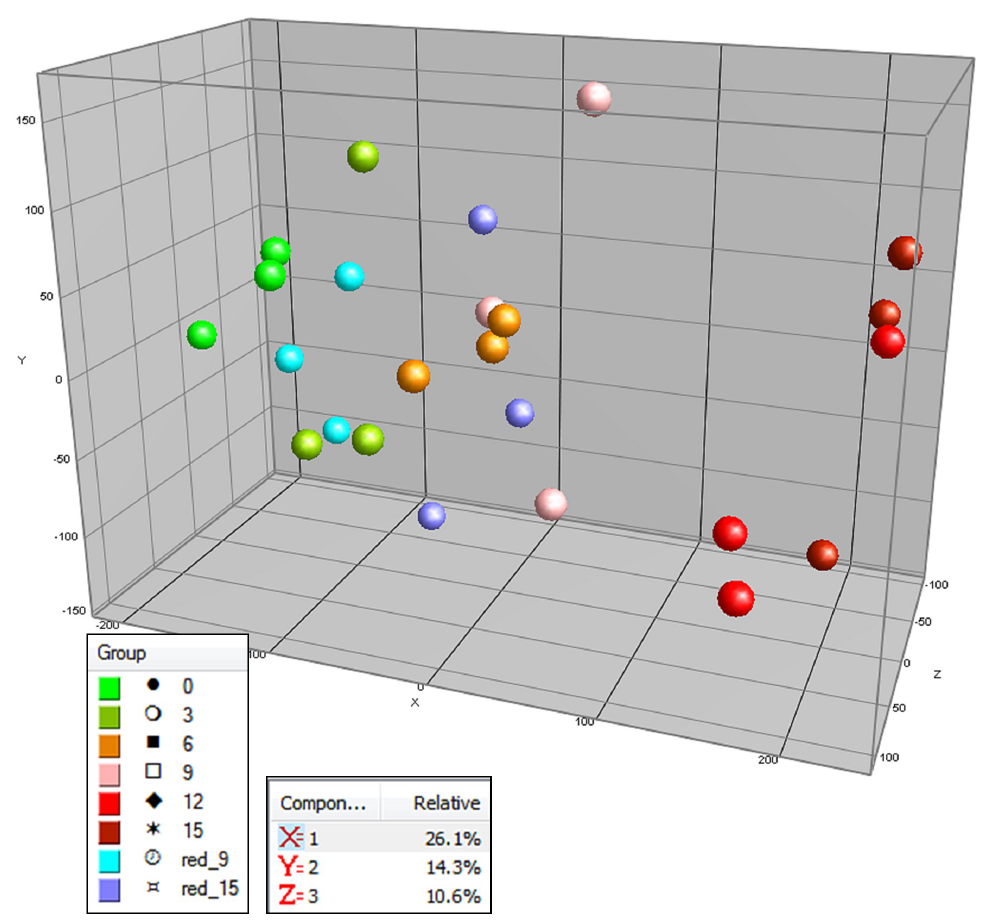
Figure 4. Principal component analysis (PCA) of tomato samples from experiment 1, based on their variations in relative abundance of 108 mainly primary metabolites detected by GCMS based untargeted metabolomics. The fruits were treated with either light (500 µ mol m − 2 s − 1 ) or darkness for 15 days. Samples of the light treatment were measured every three days and for the dark treatment at 9 and 15 days after the beginning of the experiment (t = 0 days). PC1 = X -axis = 26.1% explained variation; PC2 = Y -axis = 14.3% explained variation; PC3 = Z -axis = 10.6% explained variation. (Light treatment: t = 0 days—light green points, t = 3 days—dark green points, t = 6 days—orange points, t = 9 days—pink points, t = 12 days—light red points, t = 15 days—dark red points. Dark treatment: t = 0 days—light green points, t = 9 days—light blue points, t = 15 days—purple points.)